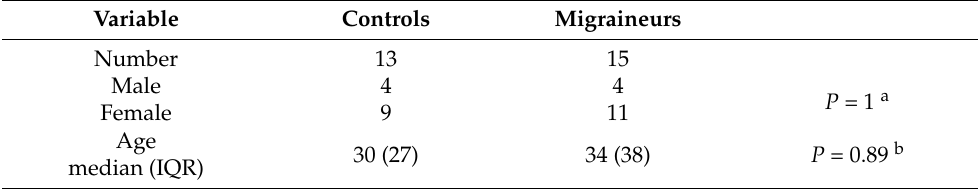
Table 1. Descriptive table comparing demographic information of patients and controls.